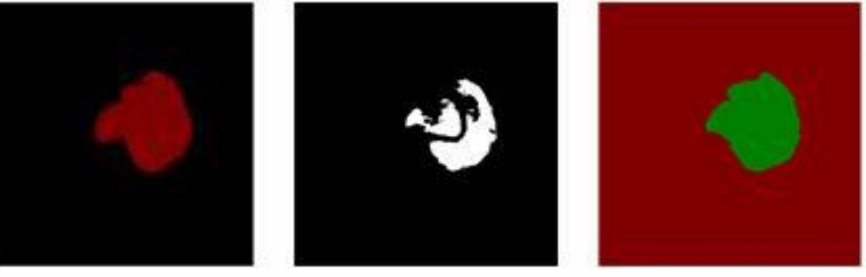
Figure 8. The renderings before and after